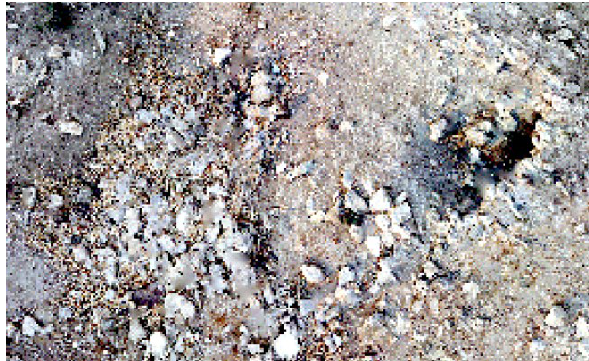
Figure 6. Detail of noisy orthophoto (terrestrial imaging)